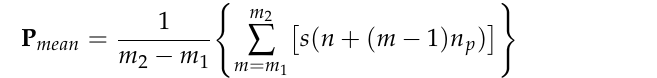
Figure 9. F-F image of the frequency spectrum of the vibration acceleration of the motor’s outer casing with a damaged bearing cage ( f P = f ip ).